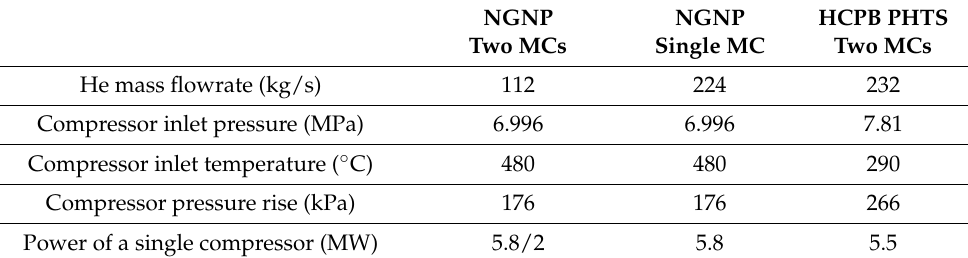
Table 5. Characteristics of the compressor for the NGNP project and DEMO HCPB